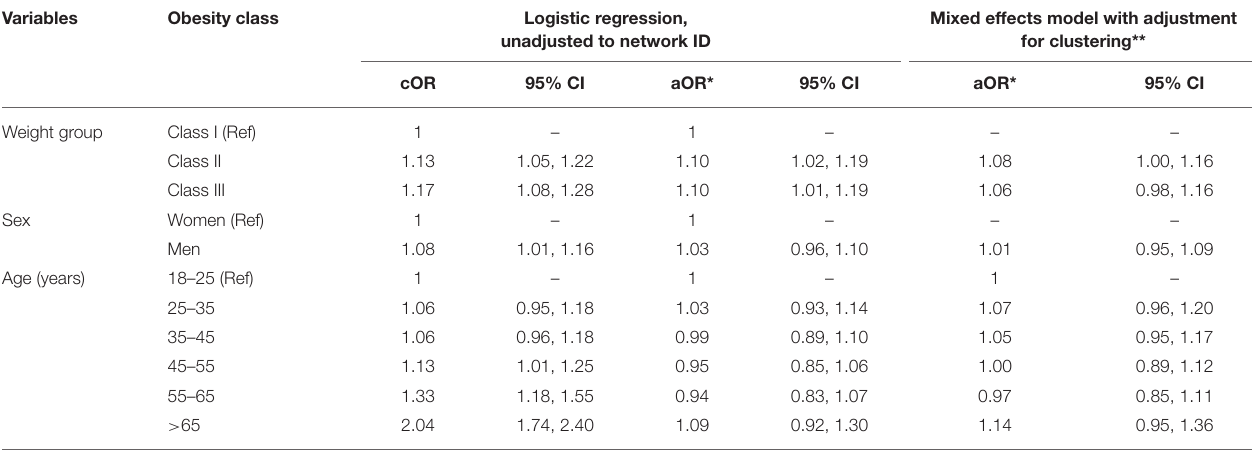
TABLE 4 | Univariable and multivariable regression analyses of the association between obesity class and AD prescribing among CPCSSN patients with depression and obesity. Variables